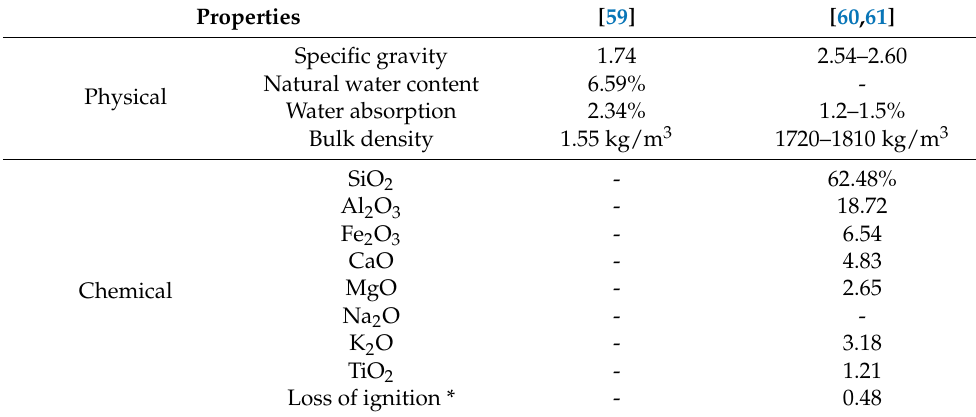
Table 1. Physical and chemical properties of QD from previous investigations.